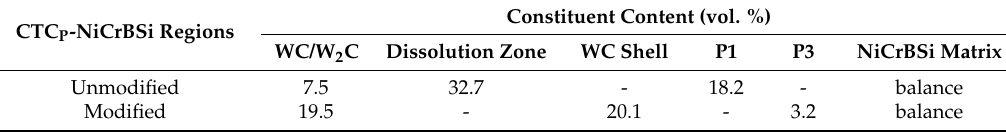
Table 1. Volume fraction of the microstructure constituent in CTC P